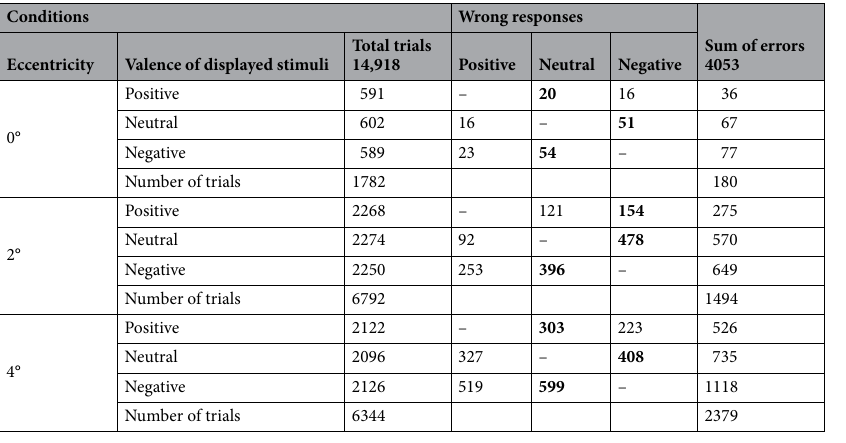
Table 4. Wrong responses distribution by eccentricity and valence. For each condition the number of trials with incorrect (wrong) responses. In bold the most frequent type of error per condition. Analysis based on trials with fixation within 1° from center. Note that “positive valence” response was not the most frequent wrong response in any condition, ruling out the possibility of the results being driven by a “positive valence” response bias. Furthermore, in 3 of the 6 parafoveal conditions the majority of the errors (wrong responses) were of a “negative valence” response, ruling out the possibility that the results are a consequence of refraining from responding “negative valence” in the